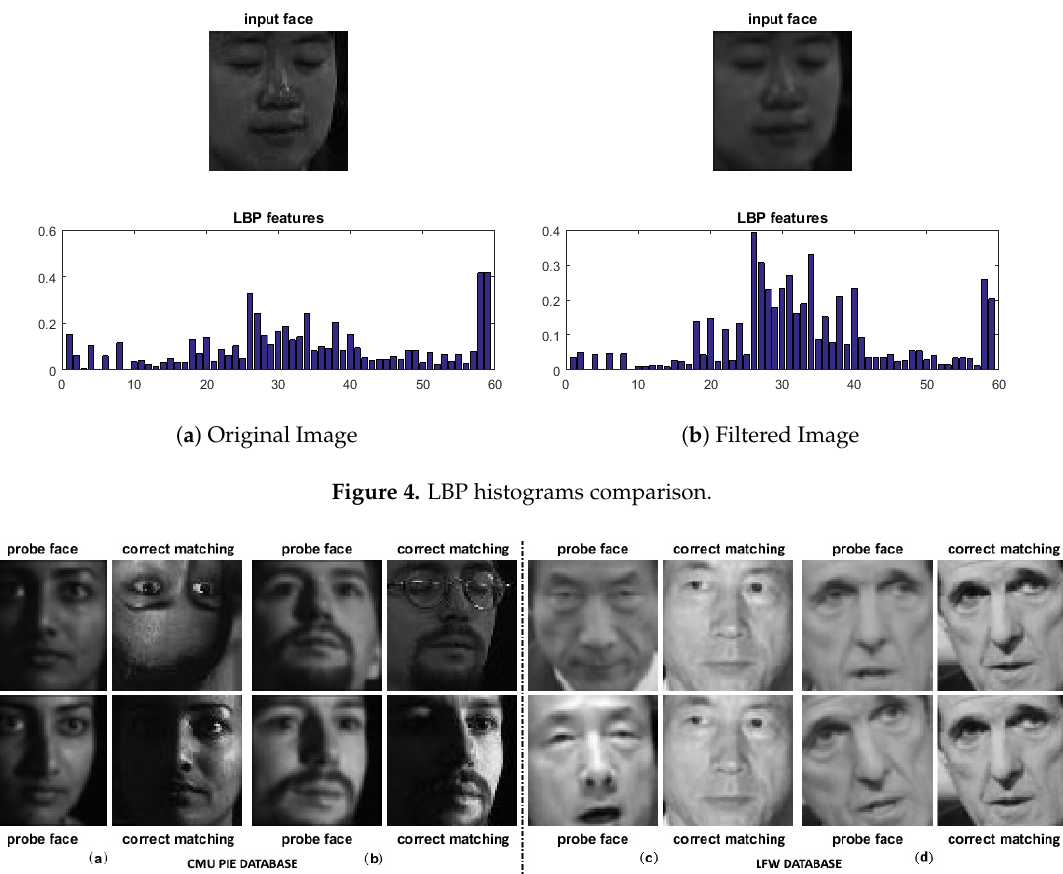
Figure 5. Correct identification. ( a , b ): CMU PIE; ( c , d ): LFW.